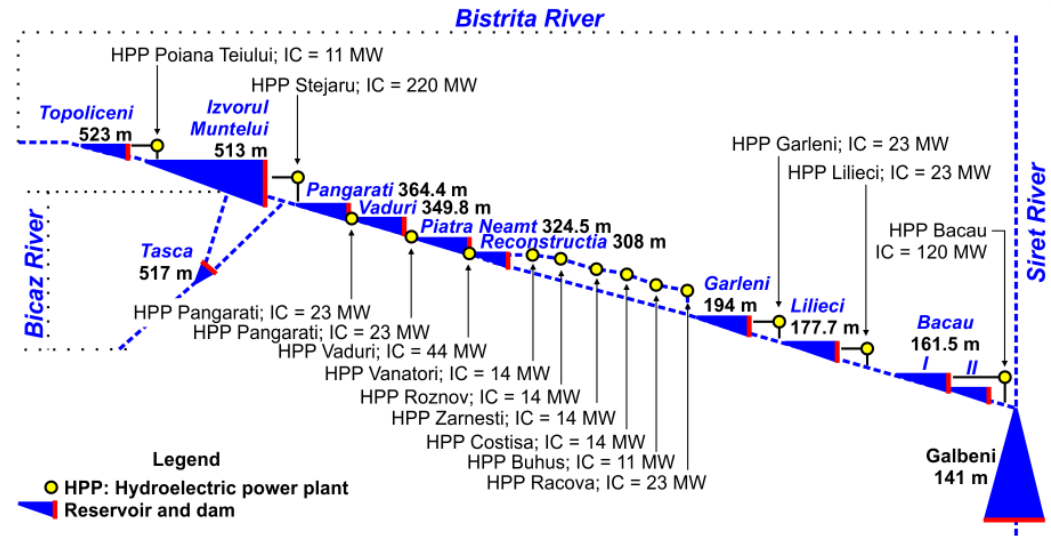
Figure 11. The complex works on the Bistrita River.